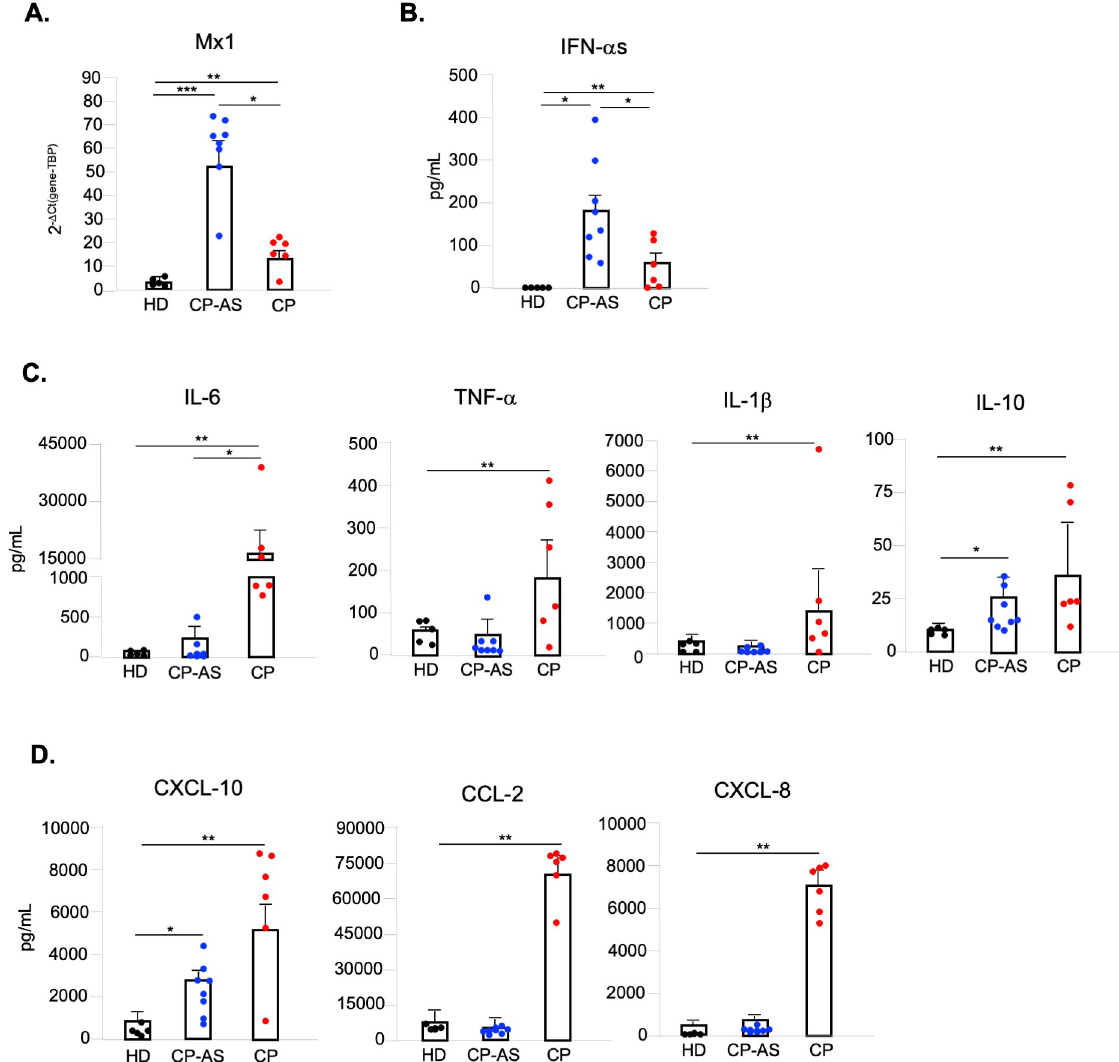
Fig 7. COVID-19 asymptomatic and hospitalized patients display a specular anti-viral and pro-inflammatory profile. Peripheral blood mononuclear cells (PBMC) and sera were collected from asymptomatic (CP-AS, n = 8) and hospitalized COVID-19 patients (CP, n = 6) as well as matched healthy donors (HD, n = 5). ( A ) Relative expression of Mx1 gene was measured by quantitative real time PCR analysis and normalized to TBP level by using the equation 2 - Δ Ct in total RNA isolated from ex vivo PBMC. ( B ) Production of IFN- α s was tested in serum samples by a specific ELISA kit. Production of cytokines (IL-6, TNF- α , IL-1 β , IL-10) ( C ) and chemokines (CXCL-10, CCL-2, CXCL-8) ( D ) was tested by multiparametric cytokine bead arrays in collected serum samples. Shown results were mean relative values ± SEM of analyzed patients or HD. P-values were depicted as follows: � p � 0.05; �� p � 0.001; ��� p �